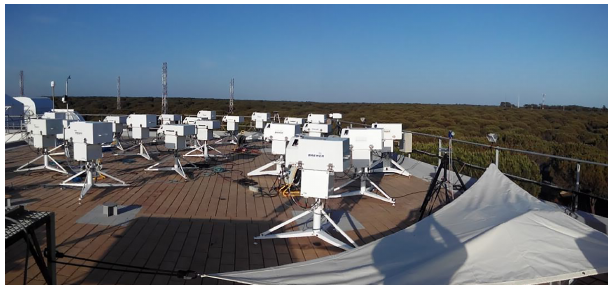
Figure 2. Panoramic view of the 21 Brewer spectrophotometers on the terrace of the El Arenosillo sounding station, Huelva, com- ing from Canada (1), the Netherlands (2), the United Kingdom (3), Switzerland (1), Finland (1), Greece (1), Denmark (2), Russia (1), Algeria (1) and Spain